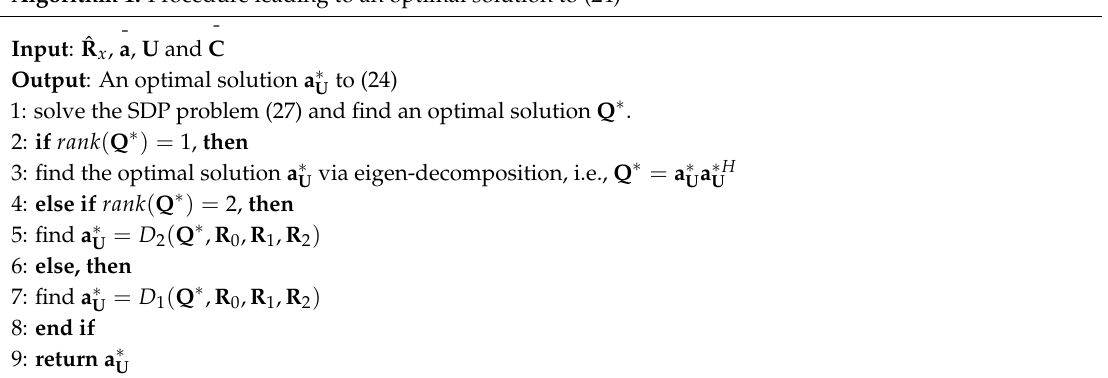
Algorithm 1. Procedure leading to an optimal solution to